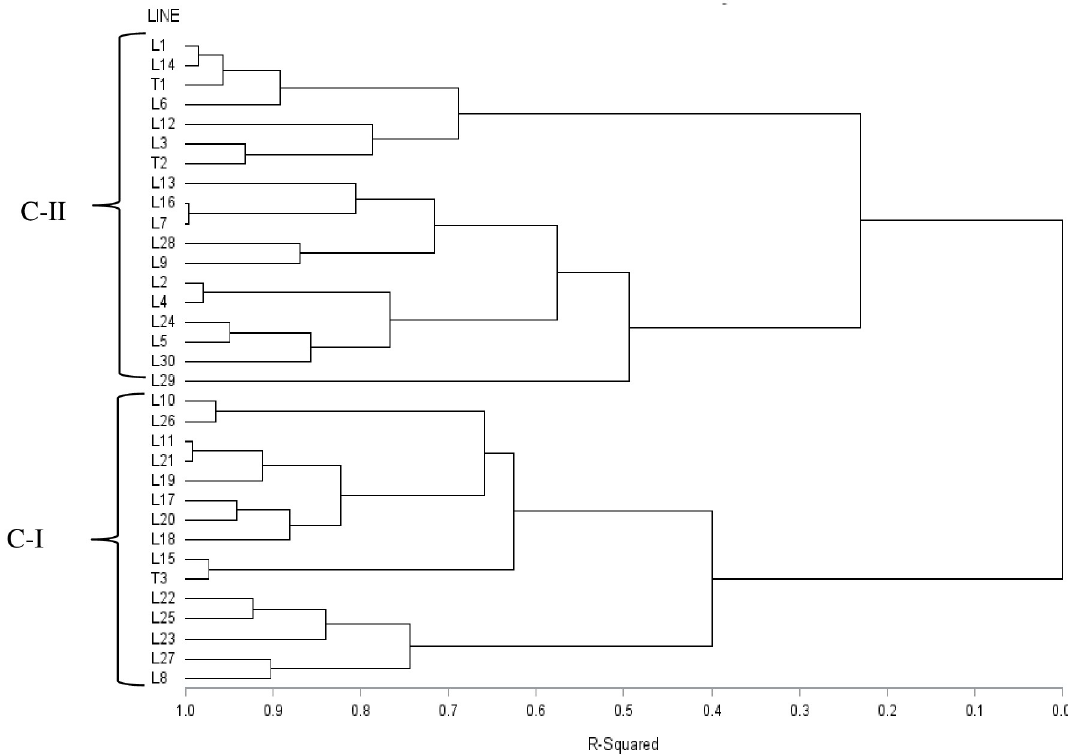
Fig 7. Dendrogram of 30 yellow maize Striga resistant inbred lines and three testers with varying levels of resistance to Striga generated by Ward from the dissimilarity matrices.